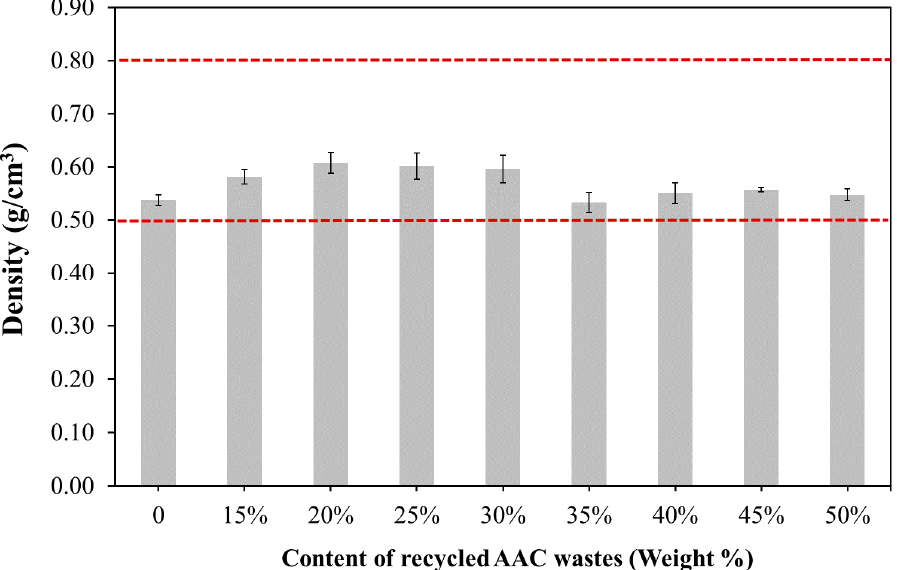
Figure 5. The density of AAC with varied fine recycling powder content (the upper and lower red dash lines indicate the acceptable range of density according to the ASTM C1692-18).